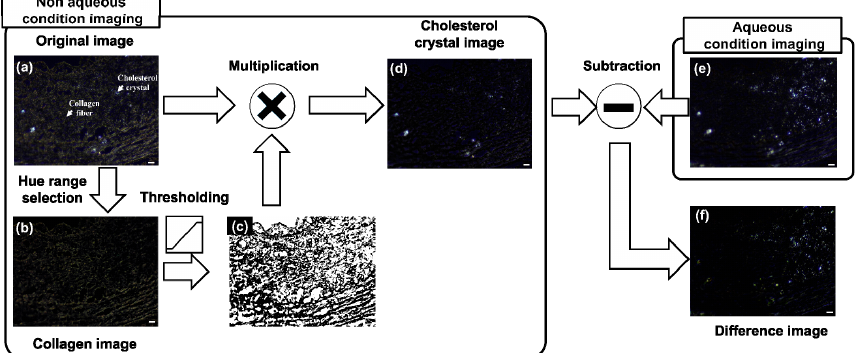
Figure 4. Schematic describing process selecting cholesterol crystals (Chcs) from a non-aqueous condition image and visualizing the difference between the non-aqueous condition image and an aqueous condition image by making a difference image. (a) Original image of non-aqueous condition; ( b ) Collagen image extracted from ( a ); ( c ) Collagen removal mask; ( d ) Cholesterol crystal image; ( e ) Original image from aqueous condition; and ( f ) difference image which is generated by subtracting ( d ) and ( e ). Scale bars: 20 μ m.